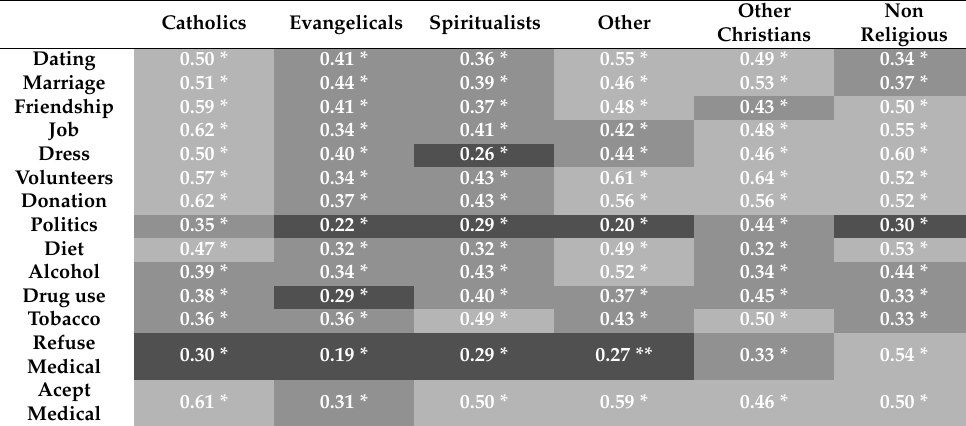
Table 2. Correlations between generic questions, daily decisions, and health-related questions. Catholics